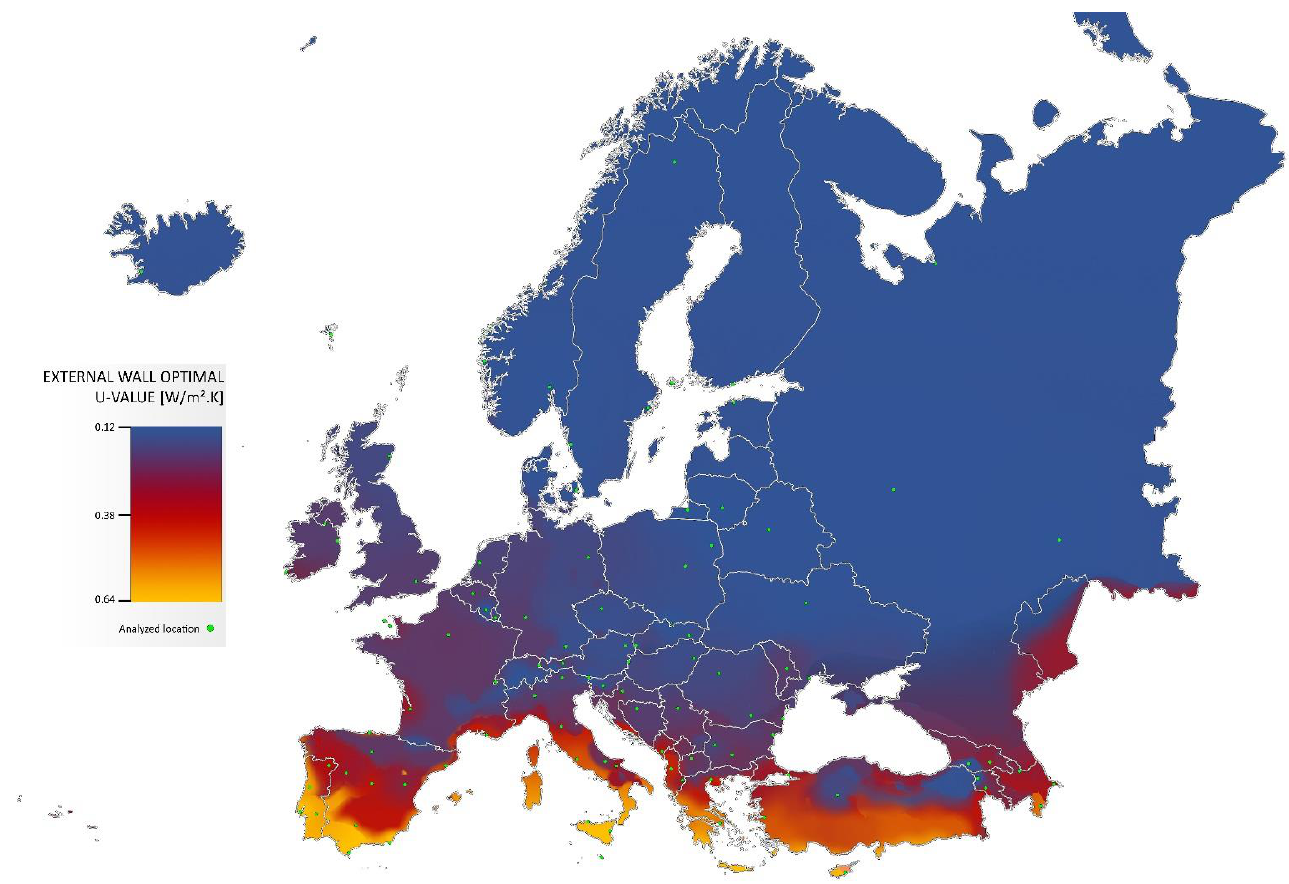
Figure 9. Optimal U-value map in Europe.